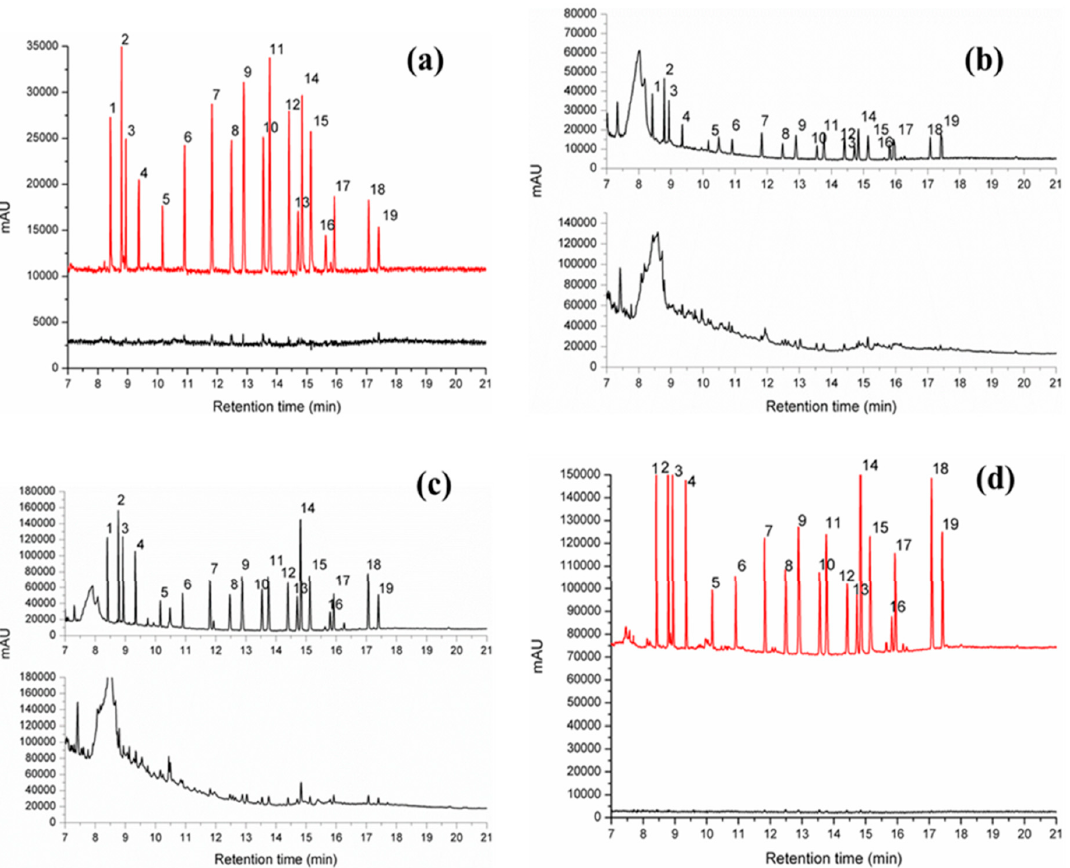
Figure 3. FPSE/GC-MS chromatograms of OCPs in real samples using sol-gel PEG-PPG-PEG coated FPSE media: ( a ) blank and spiked tap water; ( b ) blank and spiked apple juice; ( c ) blank and spiked pomegranate juice; ( d ) blank and spiked litchi juice. [Spiked concentration: 5 ppb].